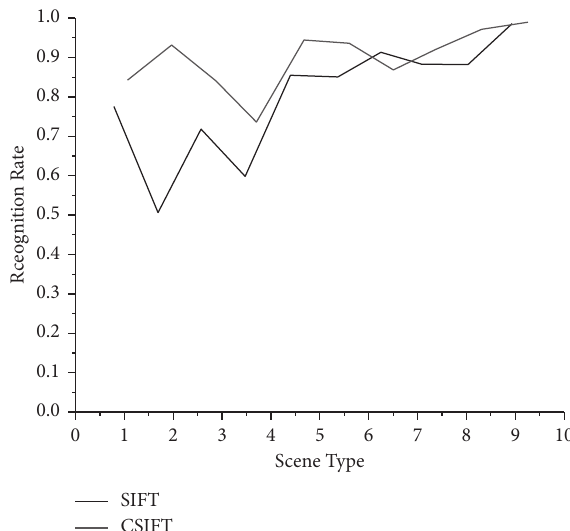
Figure 1: Scene recognition results with different low-level feature extraction